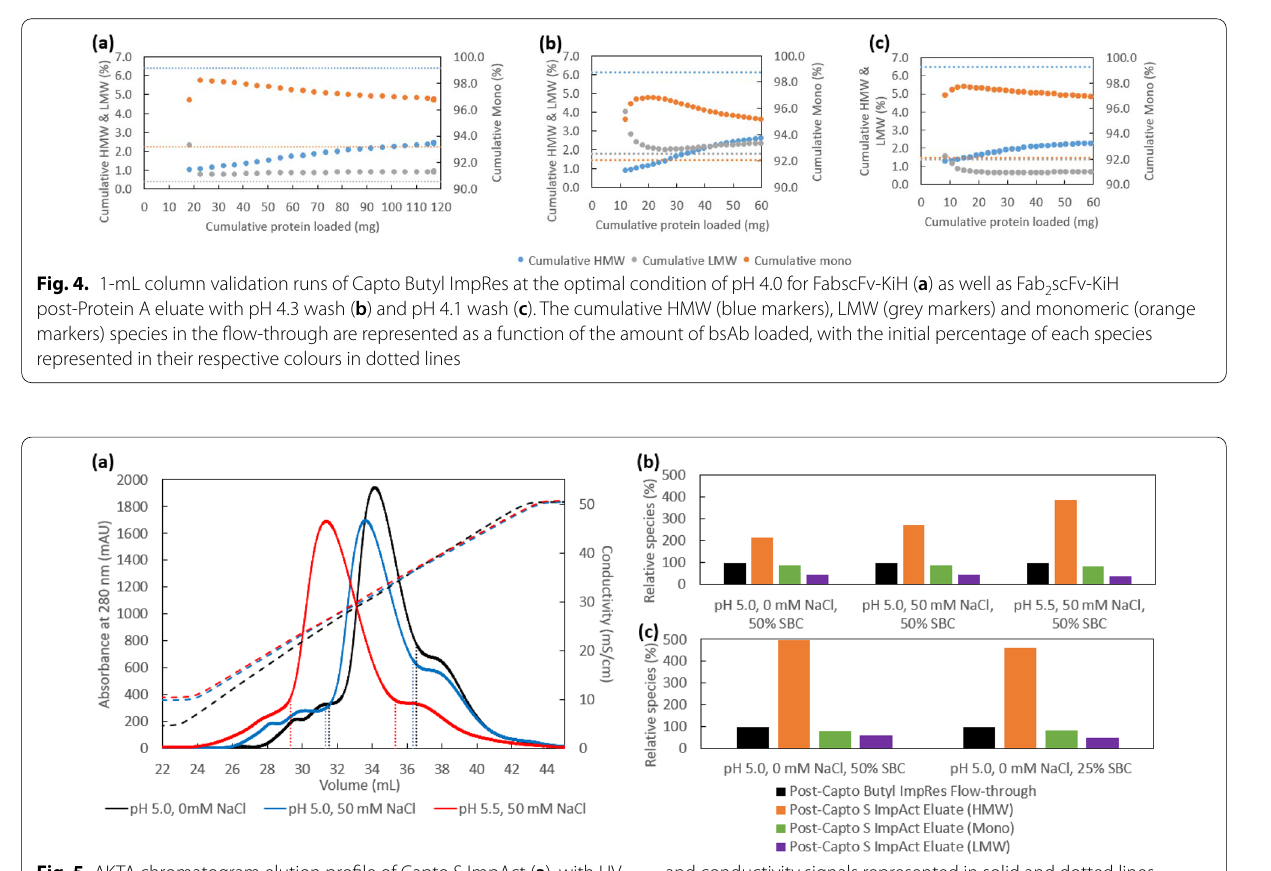
Fig. 5 AKTA chromatogram elution profile of Capto S ImpAct ( a ), with UV 280nm and conductivity signals represented in solid and dotted lines, respectively. The HMW, monomer and LMW species present in the post-Capto S ImpAct eluate relative to those in the Capto Butyl ImpRes flow-through obtained at varying pH and NaCl conditions ( b ) and different load amounts ( c ) are